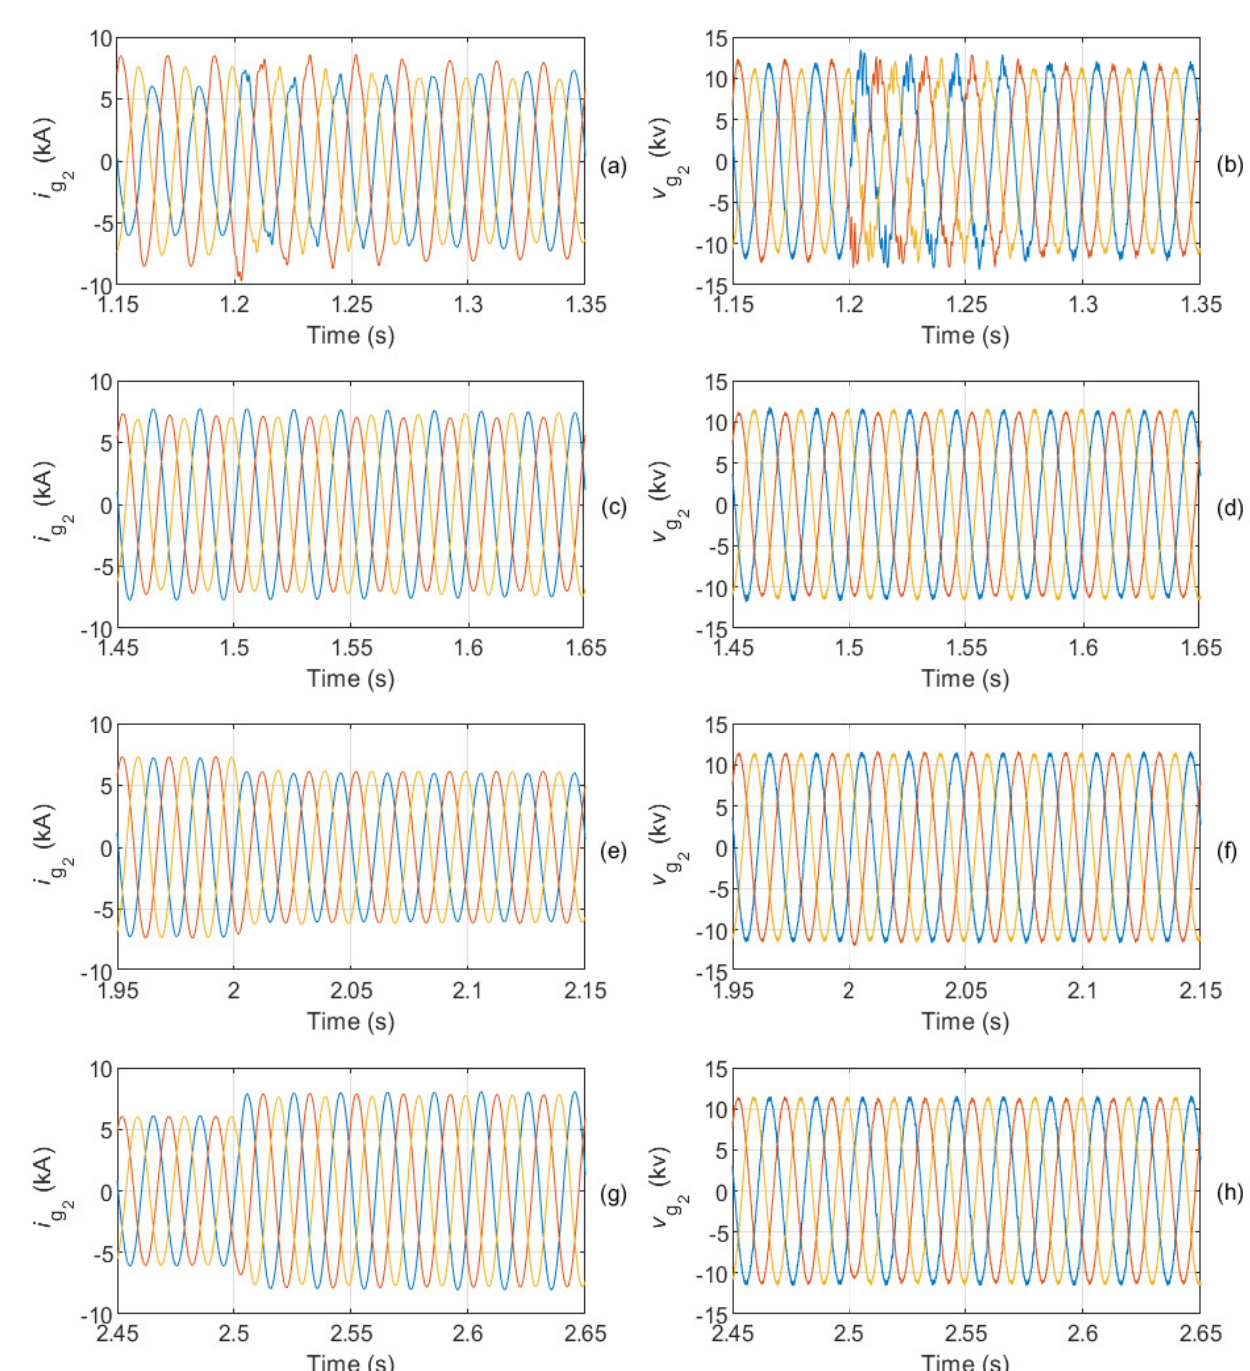
1.35 s), t ≤ ≤ 1.65 s), ( d ) line-to-neutral t ≤ ≤ 2.15 s), ( f ) line-to-neutral voltages at PCC 2 t ≤ ≤ 2.65 t ≤ ≤